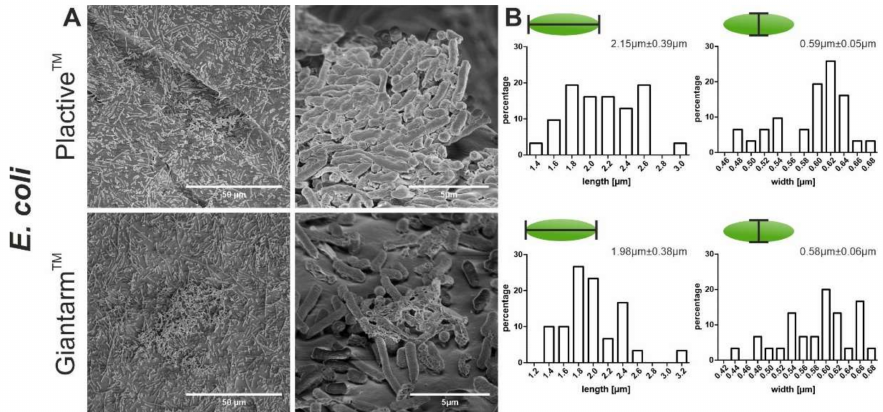
Figure 4. Scanning electron microscopy (SEM) images showing the biofilm formation and size measurement of E. coli . ( A ) The two top SEM images depict the formation of biofilm on Plactive™ PLA, and the two bottom images depict the biofilm formation on Giantarm™ PLA. ( B ) The two top graphs visualize the size distribution of the bacteria on Plactive™ PLA, and the two bottom graphs visualize the size distribution of the bacteria on Giantarm™ PLA. For all four graphs, the y axis represents the relative percentage and the x axis represents the length or width of the bacteria in